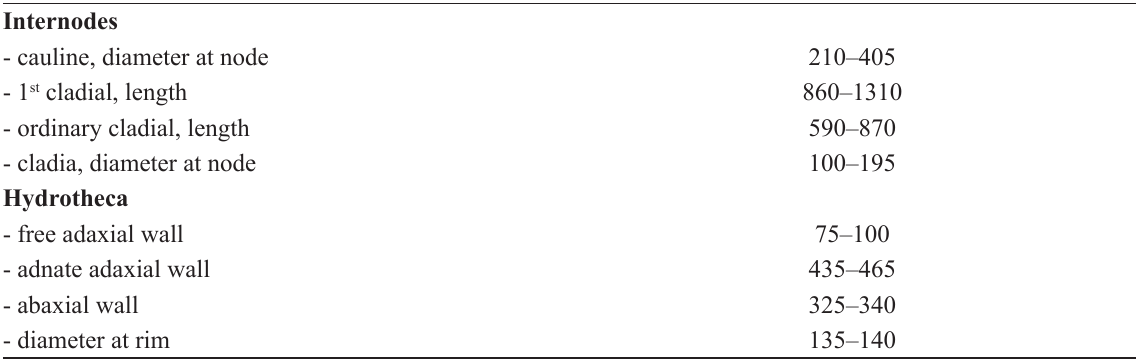
European Journal of Taxonomy 562: 1–70 Table 6. Measurements of Dynamena opposita Galea, sp. nov., in µm.